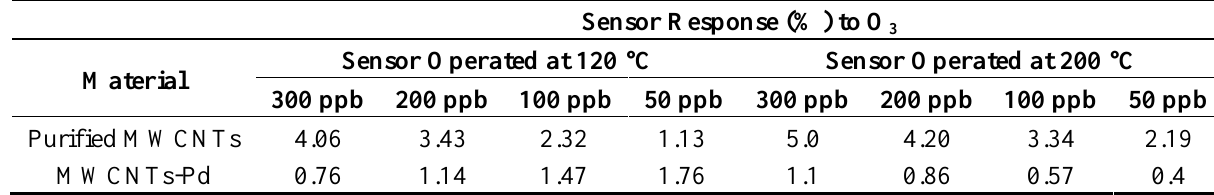
Table 1. Responsiveness of the purified MWCNT and